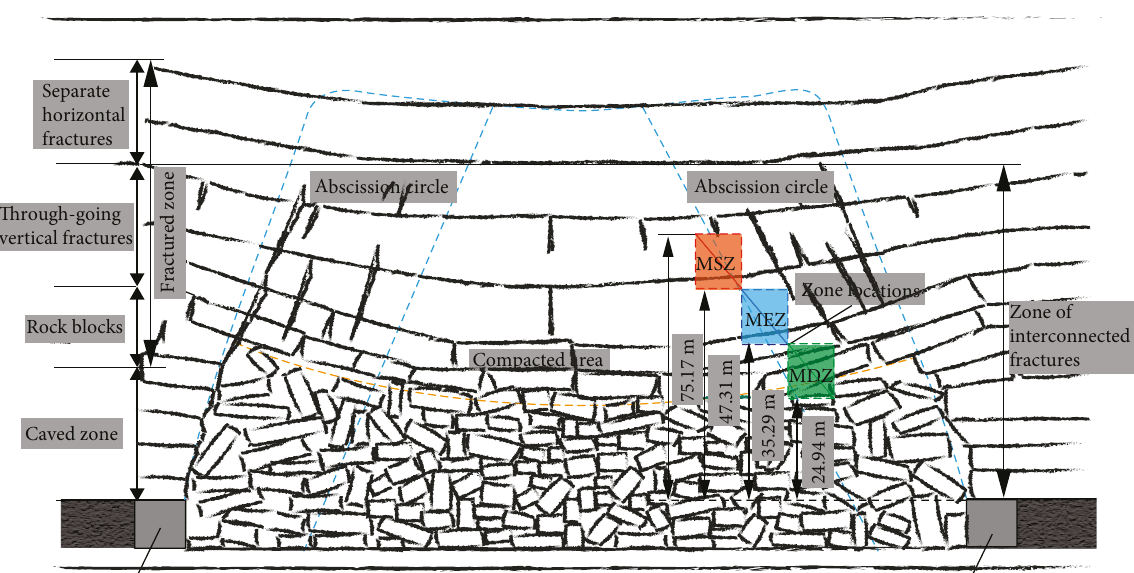
Figure 10: Schematics of the zone divisions in the incline pro fi le of the longwall